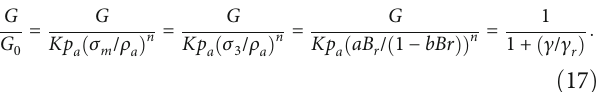
~ γ / γ fi tting for calcareous sand under di ff erent e ff ective con fi ning max r